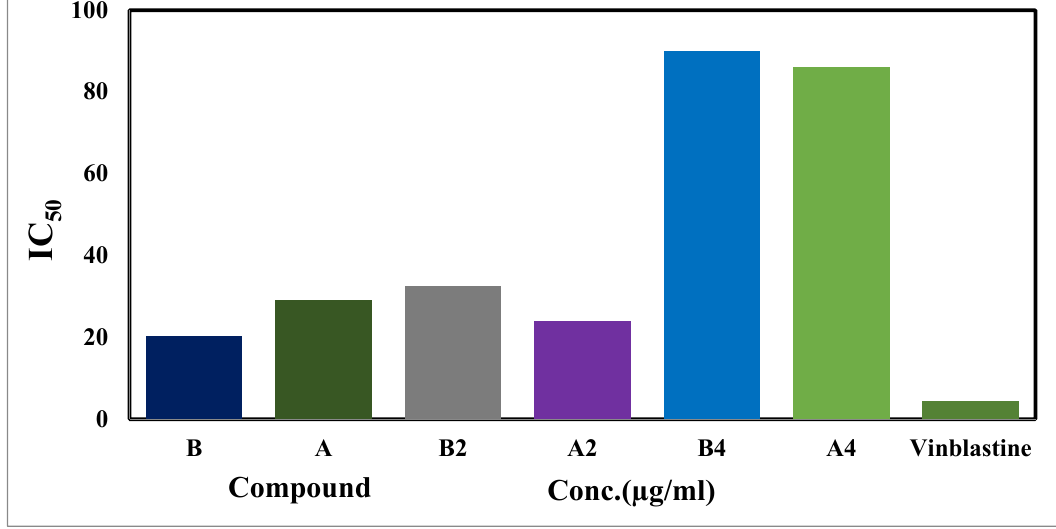
Figure 8. IC 50 values of the ligand (B, A) and Mn(II) (B 2 , A 2 ) and Zn(II) (B 4 , A 4 ) complexes before and after irradiation against the Hep-G2 carcinoma cell line compared to vinblastine.